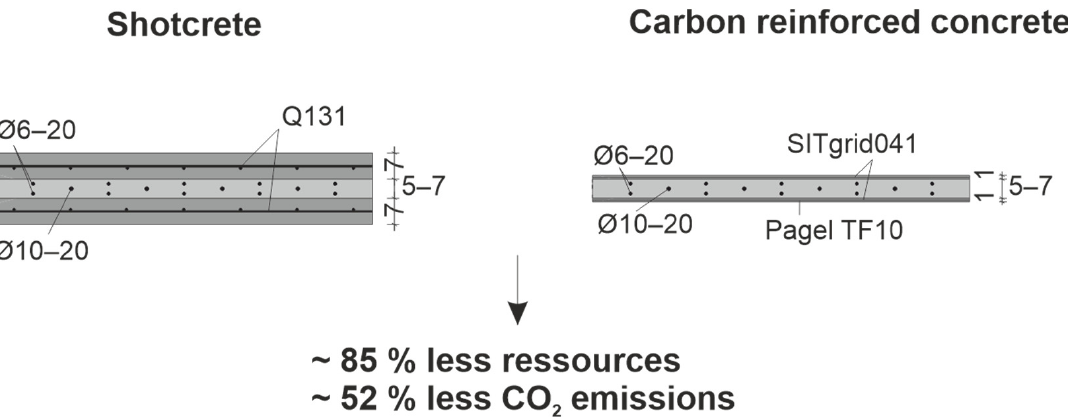
Figure 4. Comparison of strengthening with shotcrete or CRC. (Graphic: CARBOCON GMBH). By using carbon reinforced concrete, the unique structure was saved from demolition. The strengthening works were carried out between February 2020 and July 2021 (Figure 5). For more information, see